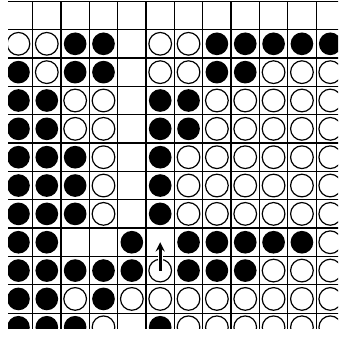
Figure 59. WHITE intrudes.